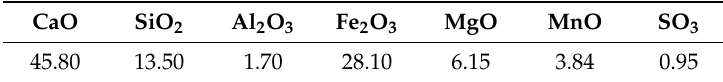
Table 4. Chemical composition of DSS in wt.